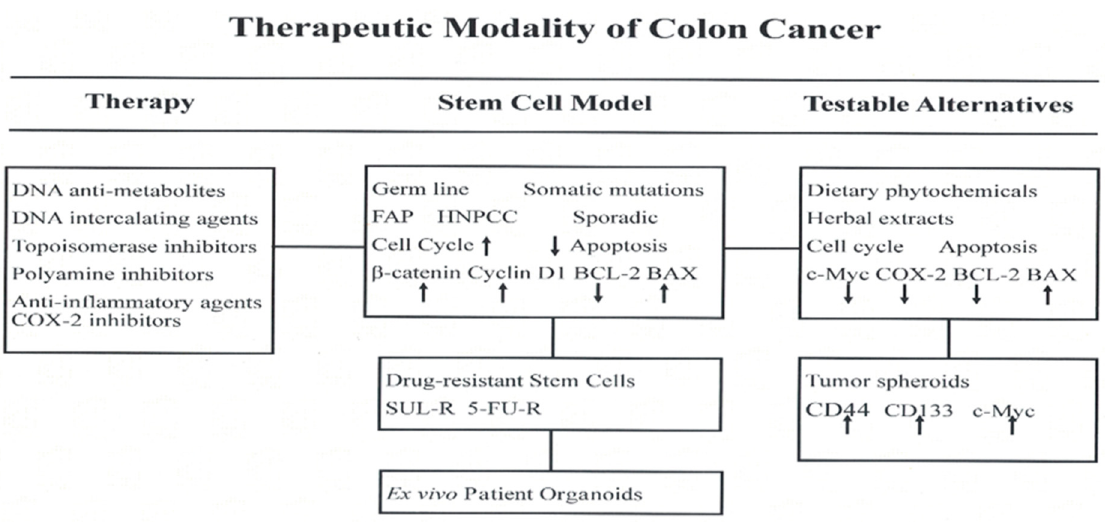
Figure 5. COX-2, cyclo-oxygenase-2; FAP, familial adenomatous polyposis; HNPCC, hereditary non-polyposis colon cancer; c-Myc, cellular myc; SUL-R, sulindac resistant; 5-FU-R, 5-fluoro-uracil resistant; BCL-2, B cell lymphoma-2; BAX, BCL-2 associated X protein; CD, cluster of differentiation.